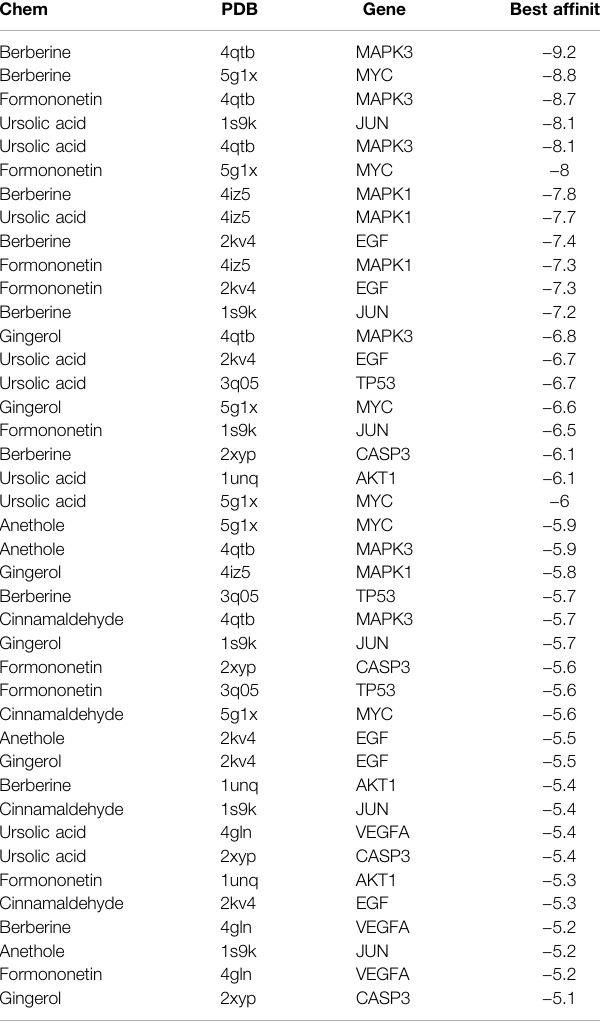
TABLE 4 | The result of molecular